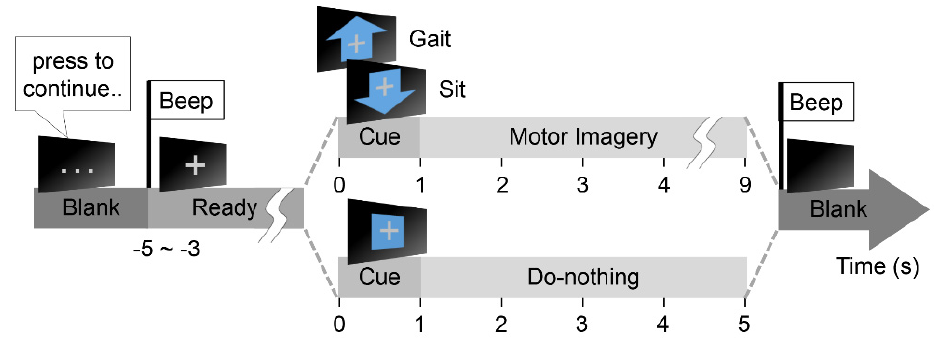
Figure 2. The o ffl ine MI procedure. Figure 2. The offline MI procedure.